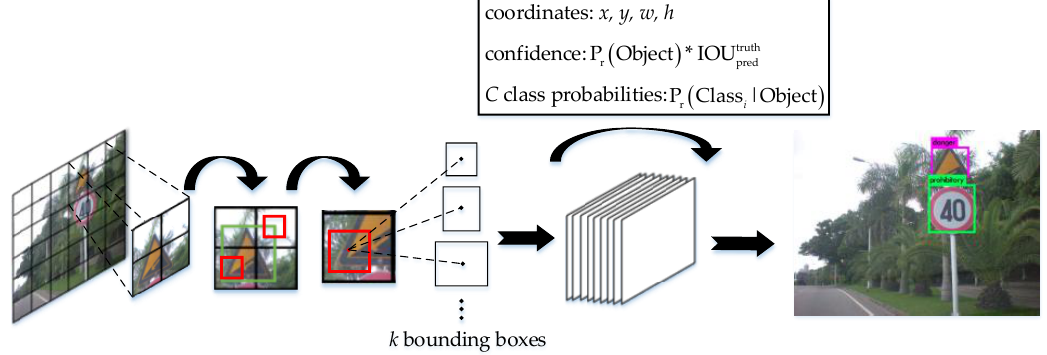
Figure 4. The Chinese traffic sign detection algorithm.